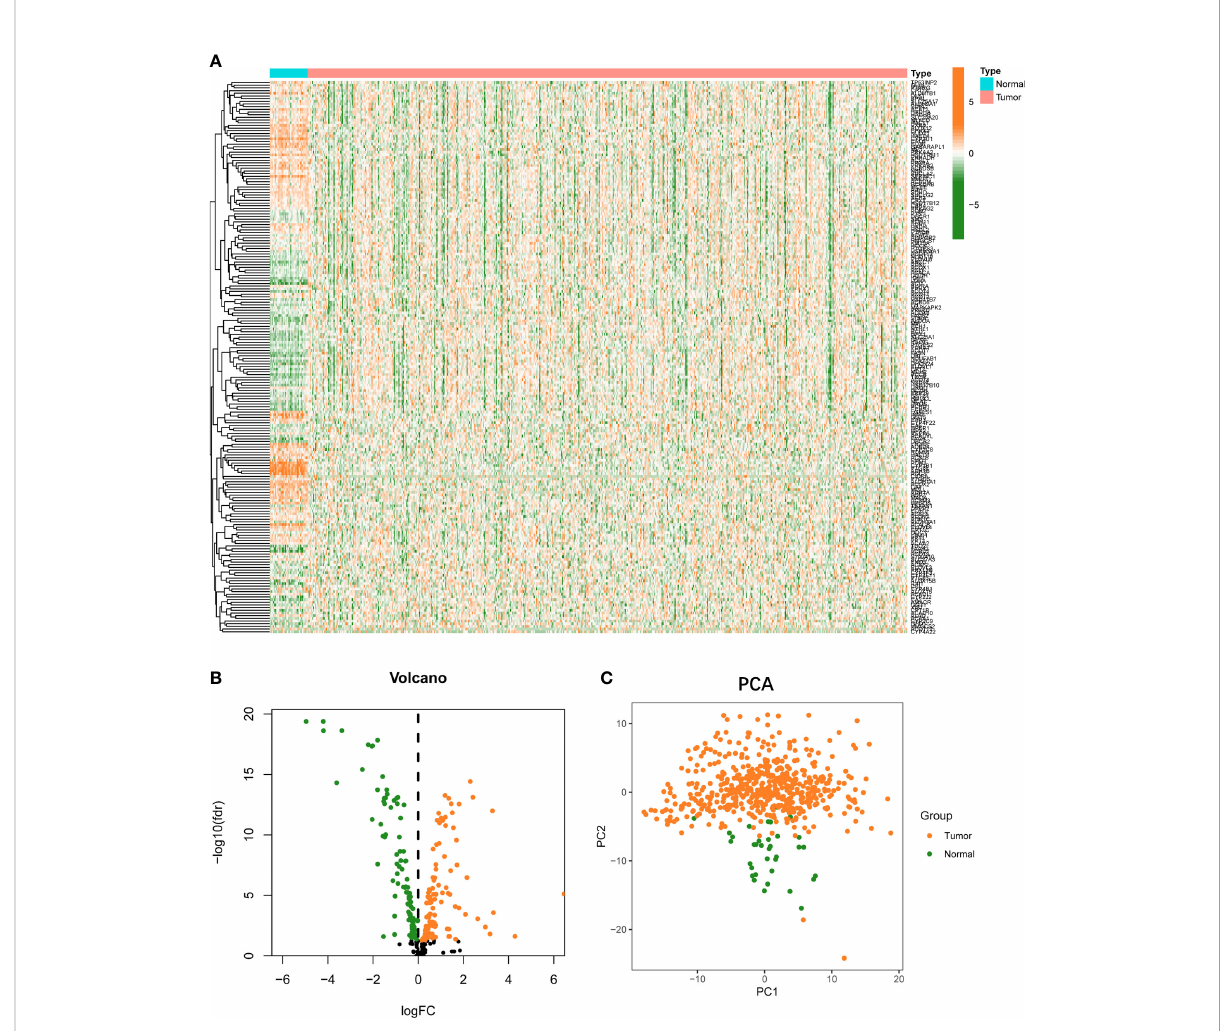
FIGURE 1 Landscape of FAMGs expressions in UCEC and normal endometrial tissues. (A) Heatmap for 309 FAMGs in TCGA cohort. (B) Volcano plot for different expressions of FAMGs. (C) PCA analysis for FAMGs to distinguish tumors (n = 554) from normal samples (n = 35). FAMGs fatty acid metabolism-related genes. UCEC: Uterine corpus endometrial carcinoma. PCA: principal component